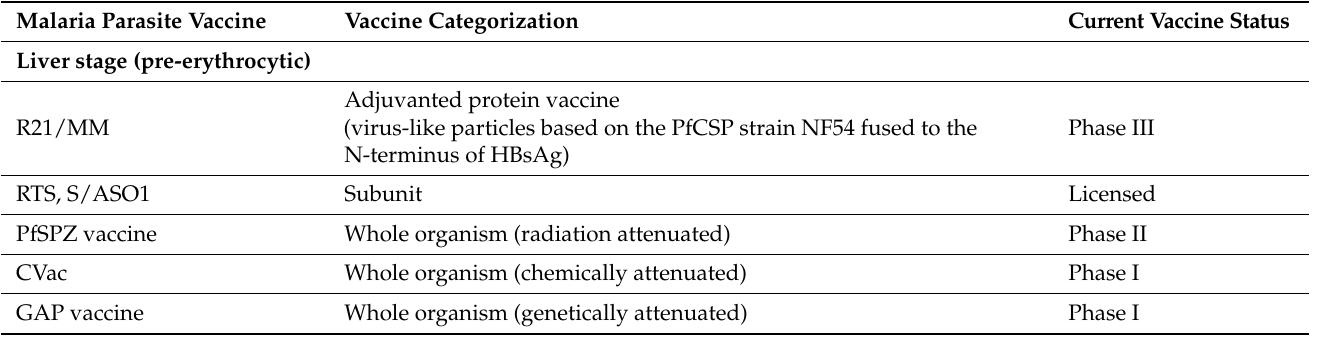
Table 1. Malaria vaccine development status regarding pre-erythrocytic, erythrocytic, and sexual stages. Malaria Parasite